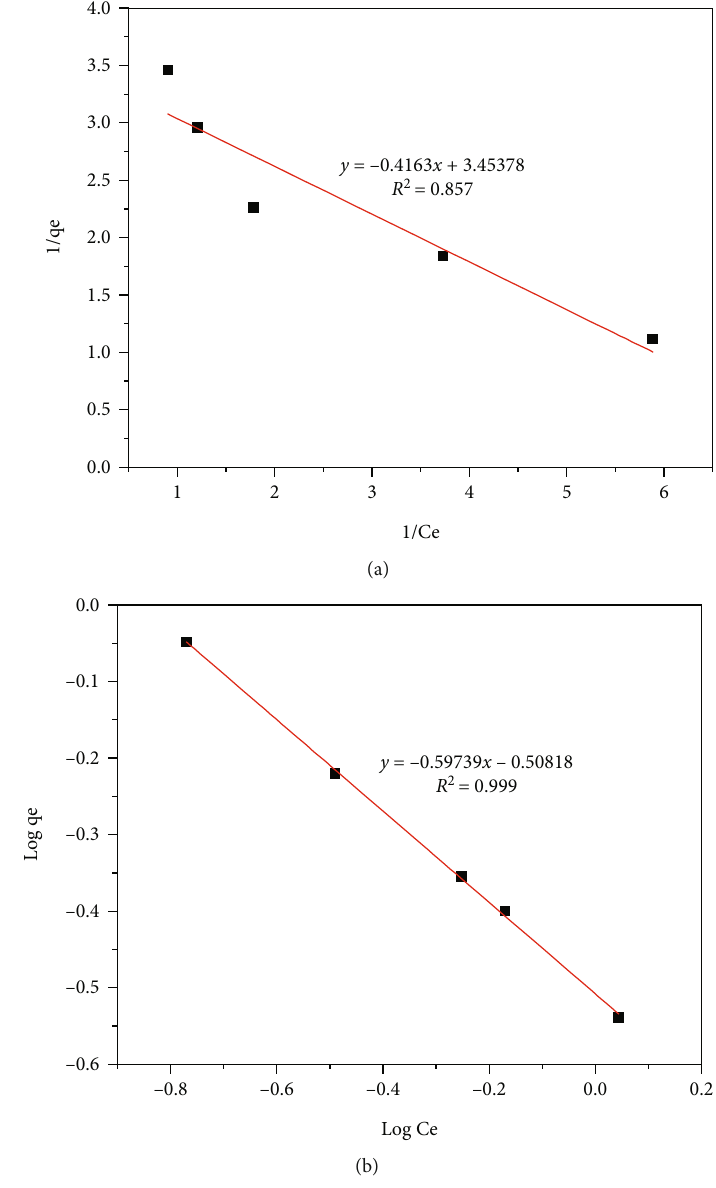
Figure 6: (a) Langmuir isotherm. (b) Freundlich isotherm by